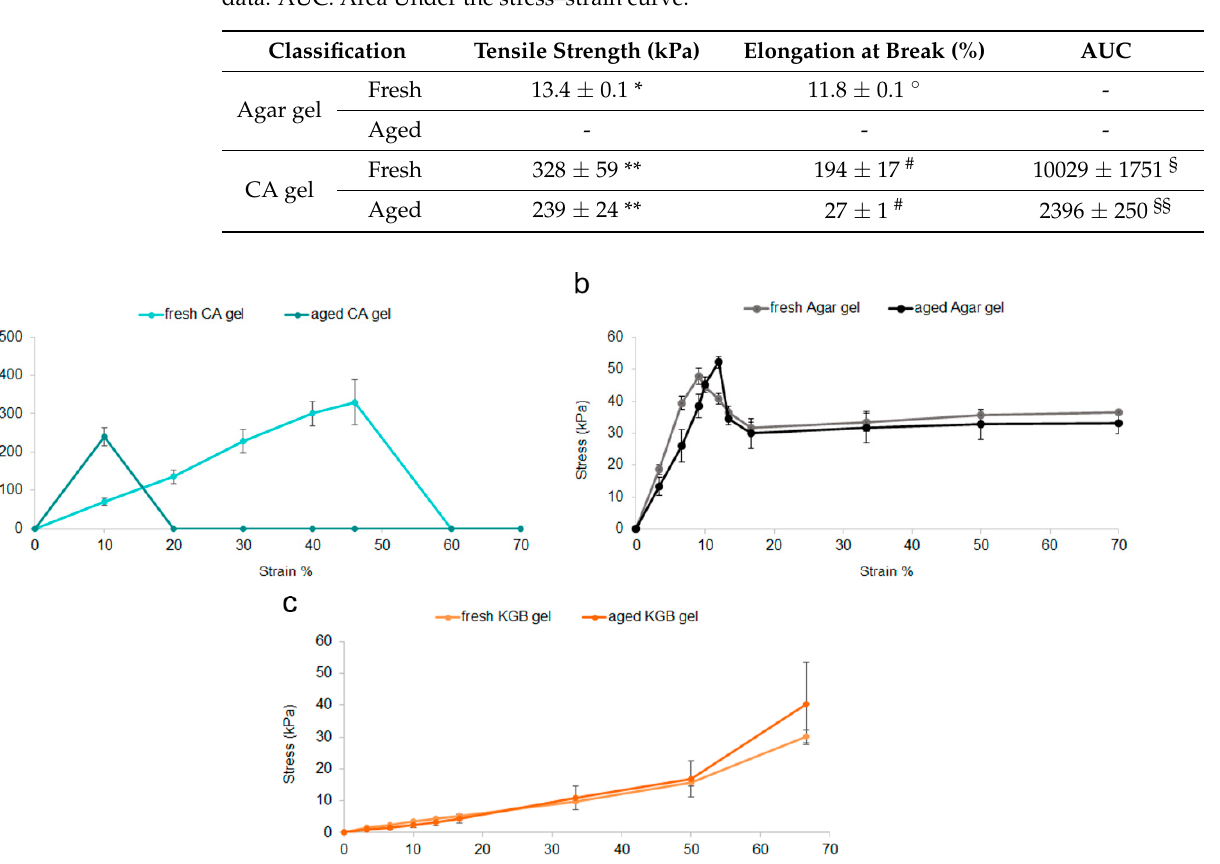
Table 1. Mechanical properties of gels determined by tensile testing (mean value ± s.d.; n = 3). ANOVA one-way, Multiple Range Test ( p ≤ 0.05): different symbols indicate statistically different data. AUC: Area Under the stress–strain curve.